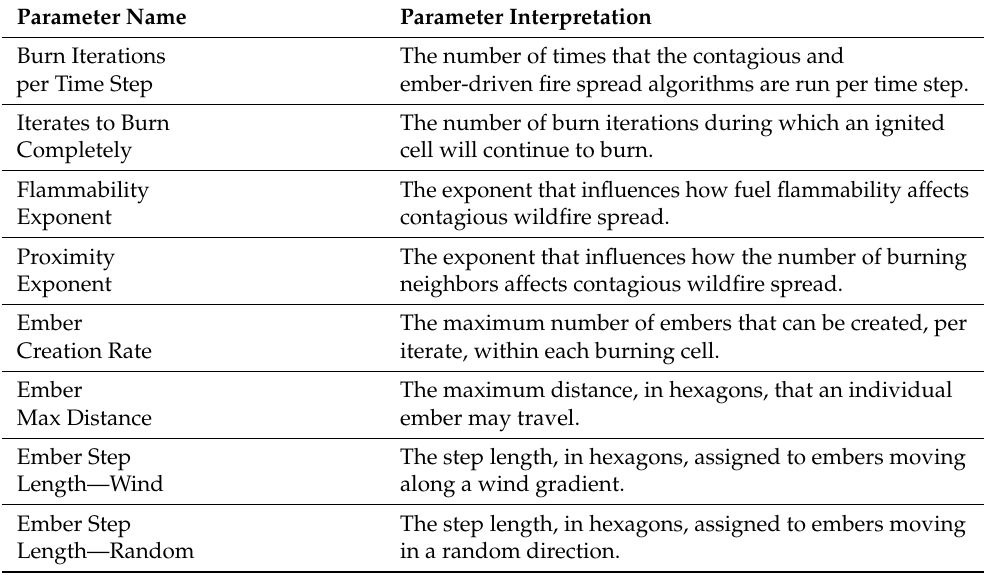
Table 1. HexFire input parameters.